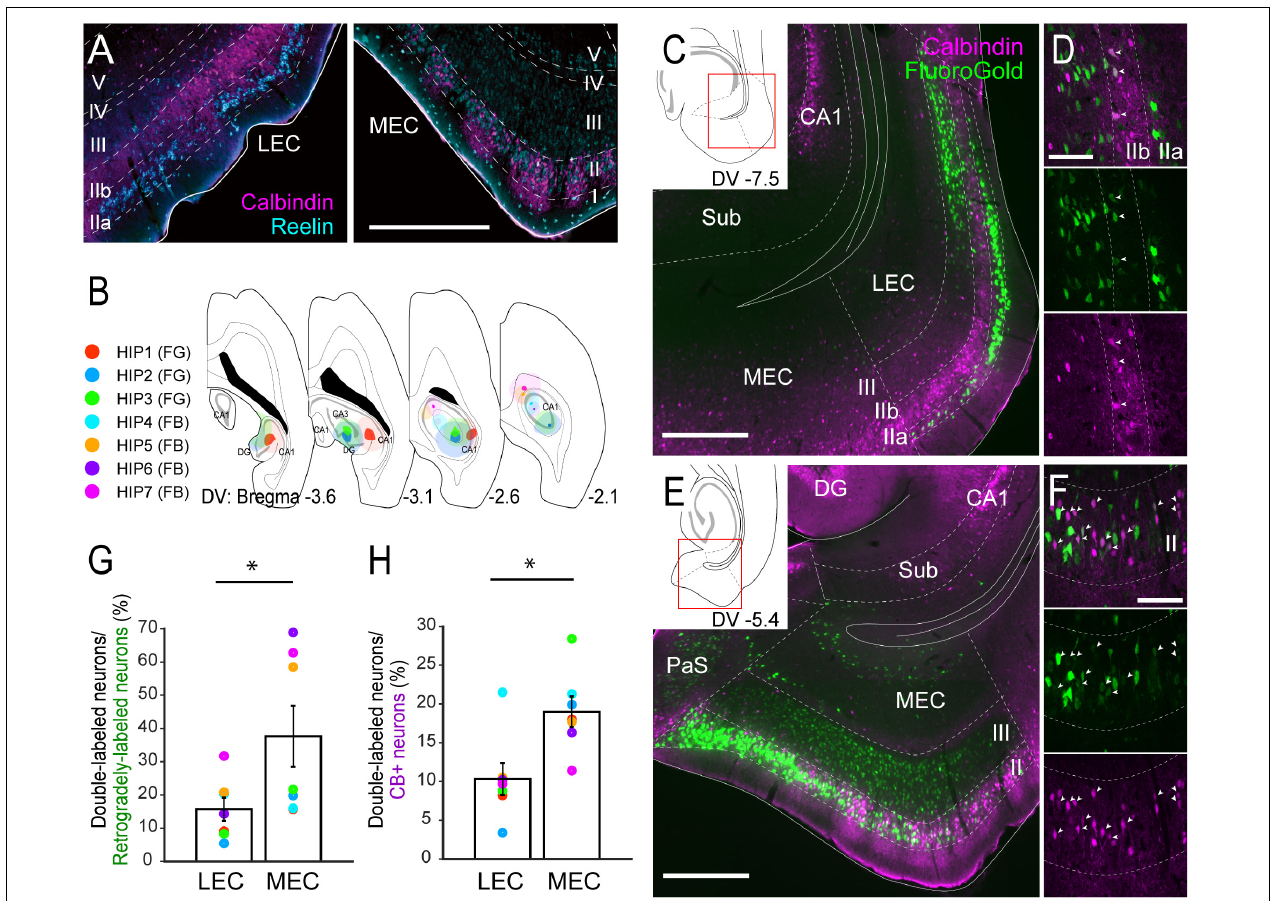
FIGURE 1 | Projections of CB+ neurons in LEC and MEC to the hippocampus. (A) Distribution of neurons immunoreactive for RE (cyan) and CB (magenta) in rat LEC and MEC. (B) The injection sites of retrograde tracers, either FG or FB, in samples with hippocampal injection. Each injection is illustrated with a different color. For all cases, the dark color shows the injection site whereas the light color shows the area of diffusion. (C–F) Distribution of retrogradely labeled neurons (green) in LEC at a dorsoventral (DV) level of –7.5 mm (C) , and in MEC at a DV level of –5.4 mm (E) in horizontal sections (case: HIP2). High magnification images of the superficial layers in LEC and MEC are shown in panels (D,F) respectively. White arrows indicate neurons that were double-labeled with FG and CB immunoreactivity. (G,H) The percentage of double-labeled neurons among retrogradely-labeled neurons (G) , and the percentage of double-labeled neurons among the CB+ neurons (H) are compared between LEC and MEC (mean ± standard errors, N = 7; ∗ p < 0.05; Wilcoxon signed rank test). Each colored dot corresponds to the value for the sample shown in panel B . Scale bars are 500 µ m for panels A,C,E , and 100 µ m for panels D,F . Sub, subiculum; DG, dentate gyrus; PaS,